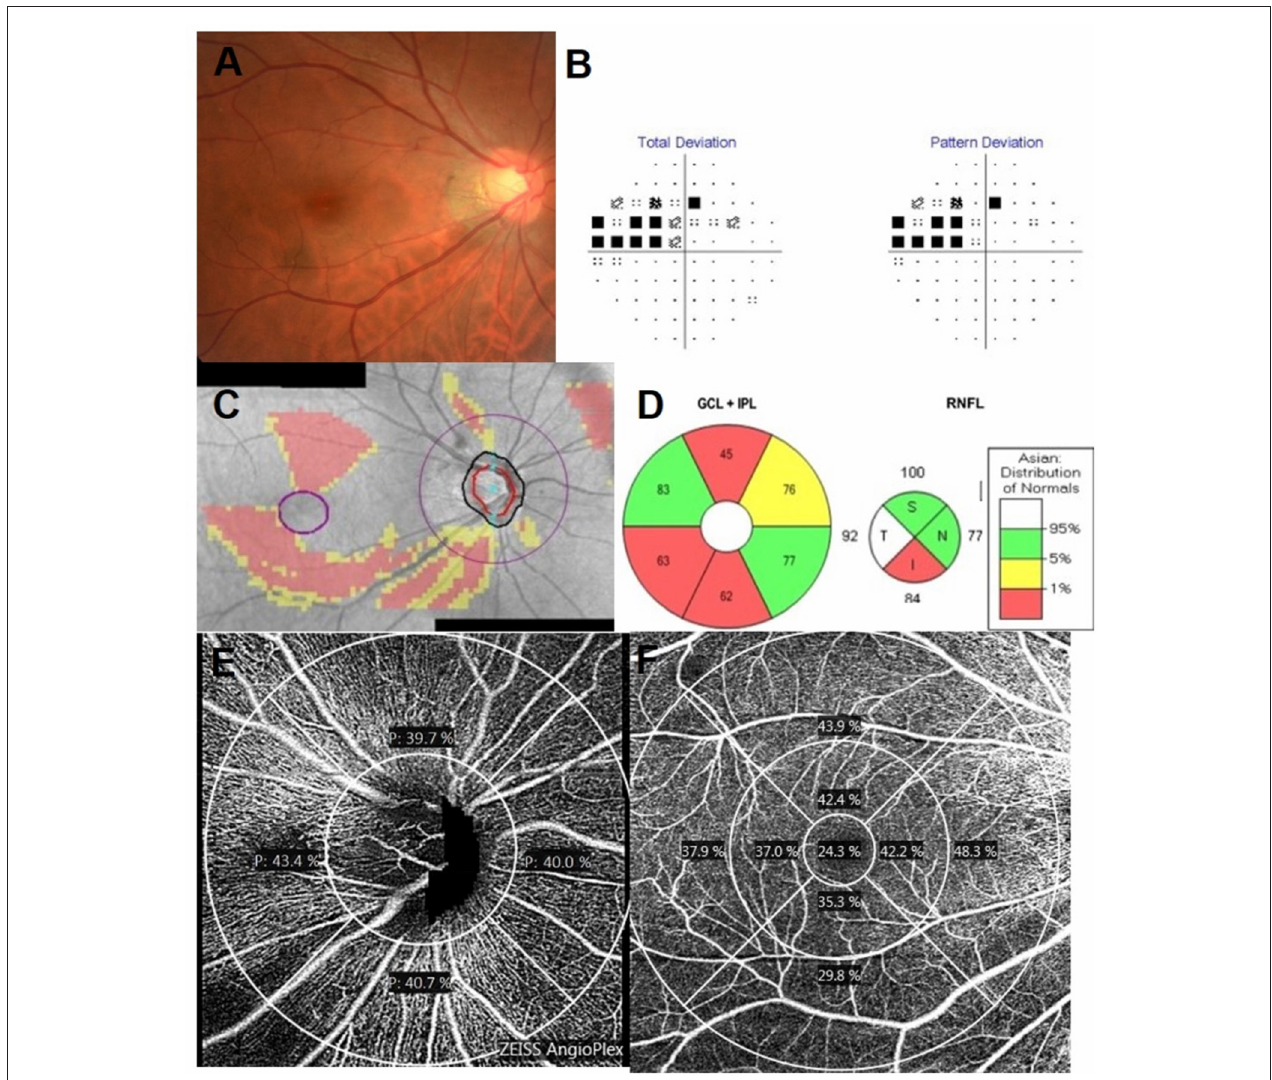
FIGURE 1 | Inferior disc excavation with inferior nerve fiber layer wedge defect of the right eye of a 42-year-old man with POAG (A) . Visual field (VF) results revealed defects at the corresponding superonasal site (B) . Combined retinal nerve fiber layer (RNFL) and GCIPL deviation maps indicated structural glaucomatous damage (C) . OCT scan showed the GCIPL thickness ( µ m) provided by the ganglion cell analysis report [ (D) , left] and RNFL thickness ( µ m) ( (D) , right) in each sector. OCT angiography image (Cirrus HD-OCT, version 11) of a 4.5mm × 4.5mm scan (E) exhibited radial peripapillary superficial perfusion (%) and a 6mm × 6mm scan (F) exhibited the superficial vessels at the macula. The grids represented the sectors across which the perfusion density (%) was calculated. The area between the inner two circles in the 6mm × 6mm scan represented the inner sectors, and the area between the outer two circles represented the outer sectors. GCIPL, ganglion cell-inner plexiform layer; OCT, optical coherence tomography; I, inferior; IN, inferonasal; IT, inferotemporal; N, nasal; S, superior; SN, superonasal; ST, superotemporal; T,